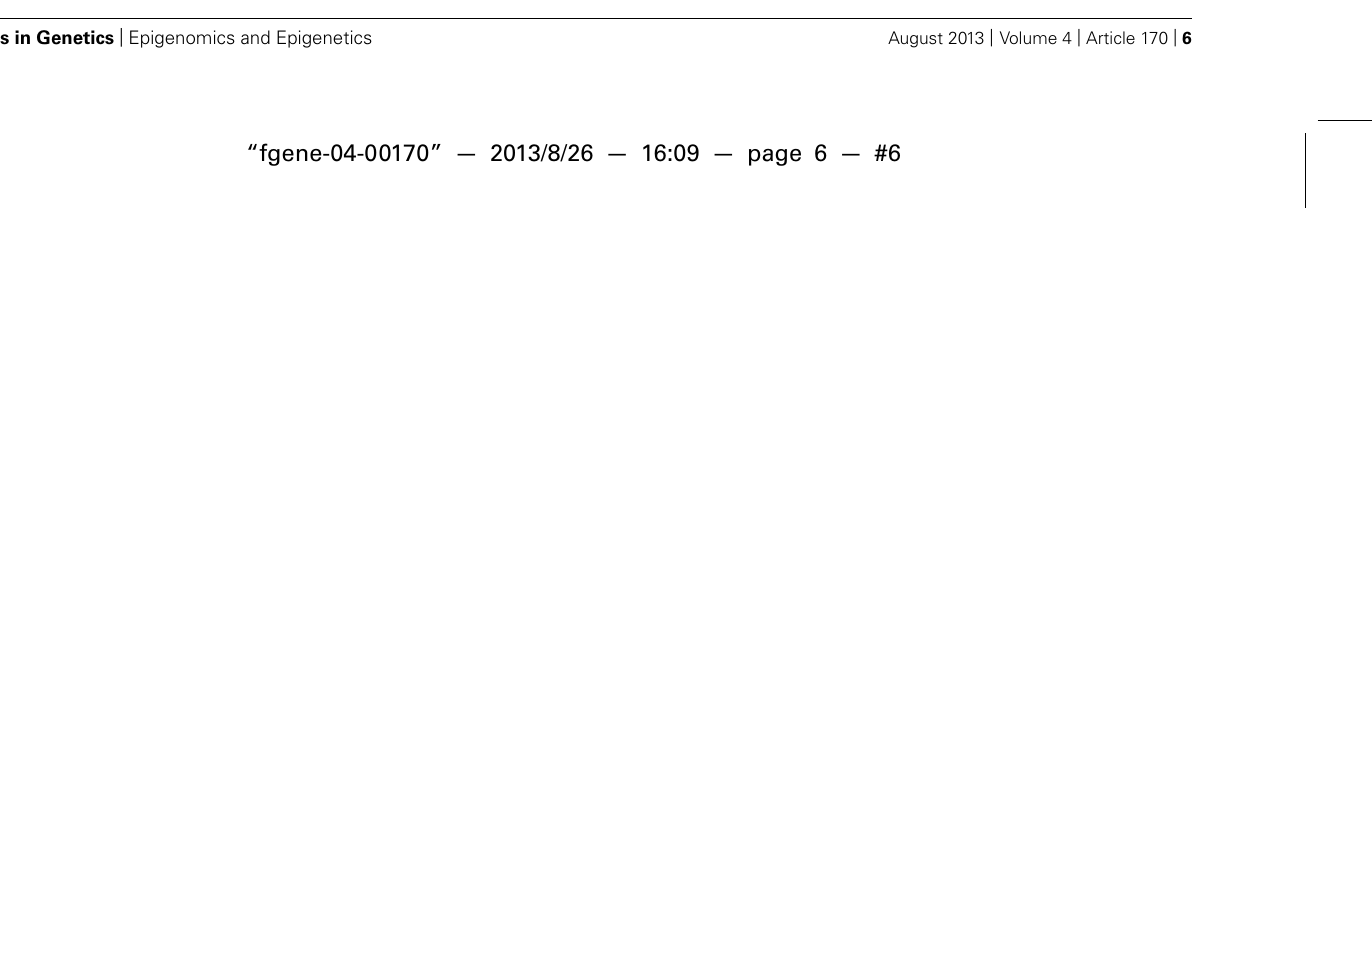
alleles carried, leads to upregulation of Activin-A. Excreted Activin-A is subsequently able to upregulate Nodal, and potentially STOX1, in fetal extravillous